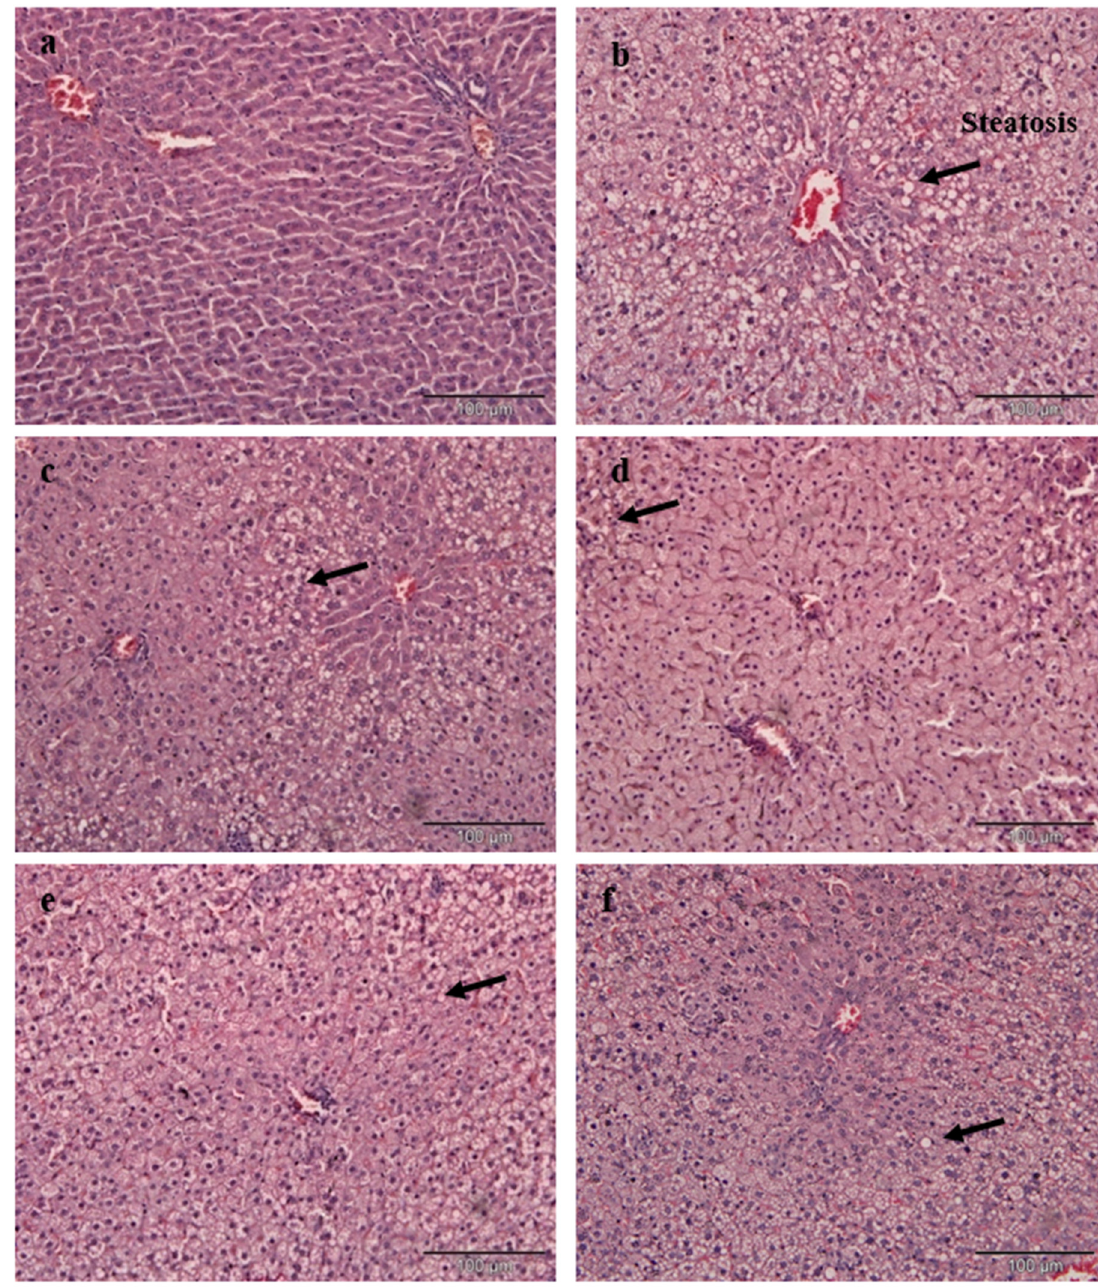
Figure 2. Histopathology of rat liver tissue in different groups. ( a ) NC—Normal control, ( b ) PC—Positive control with high cholesterol diet (1%), ( c ) SV—High cholesterol diet (1%) with simvastatin (10 mg/kg body weight), ( d ) EAMMS50—High cholesterol diet (1%) with ethyl acetate Mikania micrantha stem extract (50 mg/kg body weight), ( e ) EAMMS100 High cholesterol diet (1%) with ethyl acetate Mikania micrantha stem extract (100 mg/kg body weight), ( f ) EAMMS200—High cholesterol diet (1%) with ethyl acetate Mikania micrantha stem extract (200 mg/kg body weight). Livers were stained with hematoxylin and eosin (H&E) and visualized under a light microscope at 100× g magnification.